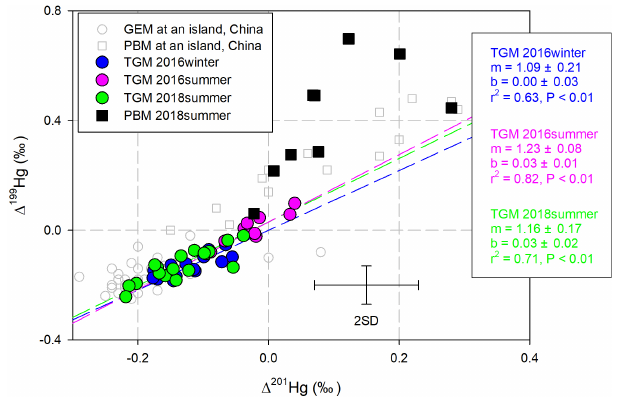
Figure 4. Scatter plot of (cid:49) 199 Hg and (cid:49) 201 Hg in the TGM and PBM samples, illustrated with reported data obtained at Huaniao island sites in the East China Sea (Fu et al., 2018, 2019a). Regres- sion lines were colored to match the TGM scatter plots. Error bars refer to 2 σ for samples in this